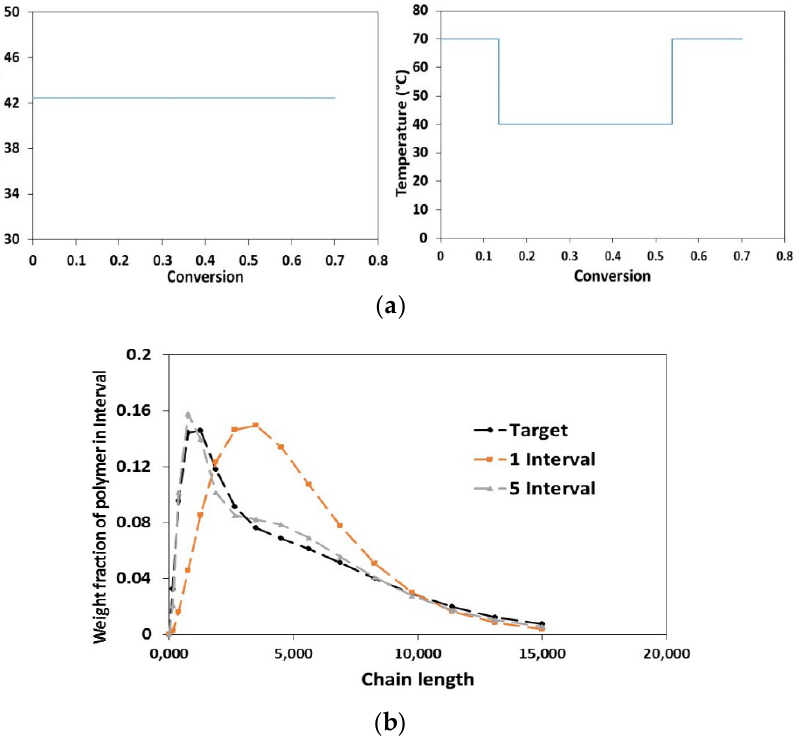
Figure 5. Optimization results: ( a ) Temperature profiles; ( b ) Molar mass distribution.